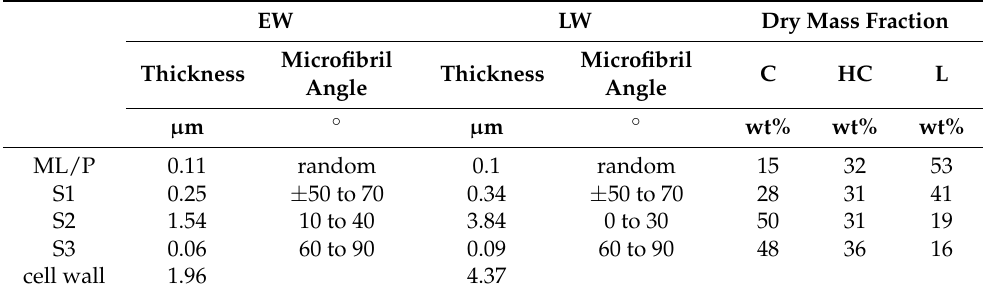
Table 2. Structural composition of EW and LW tracheids.